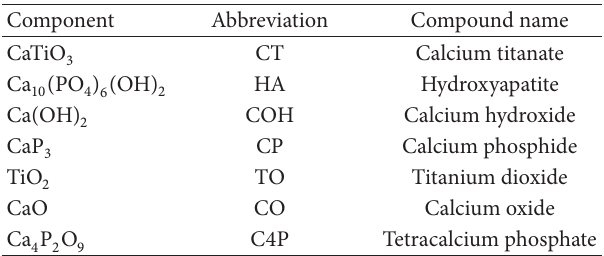
Table 1: Components, abbreviations, and compound names in X- ray diffractogram